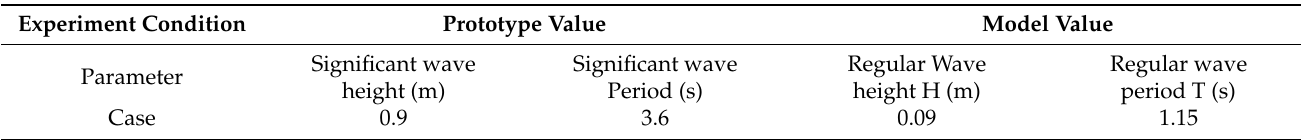
Figure 10. The whole model: ( a ) model composition, ( b ) motion reference unit 5th generation [48]. Table 2. Experiment